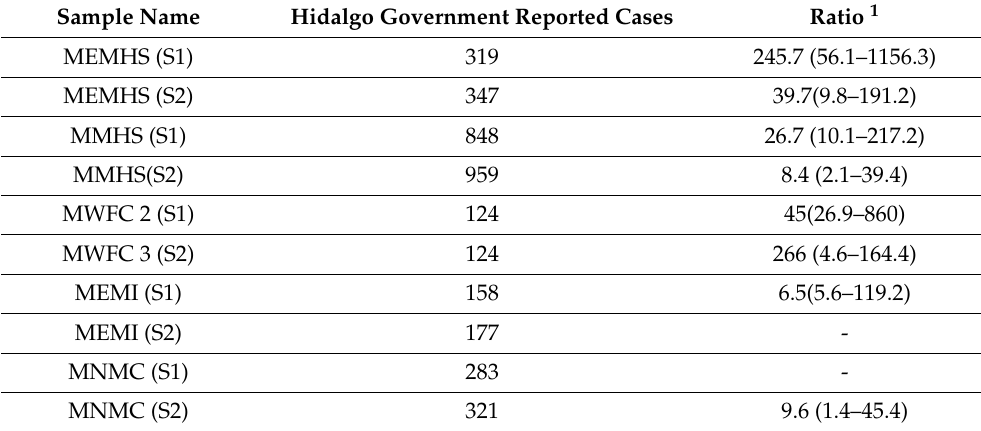
Table 3. Times greater of infected people reported in the model in comparison with official reported